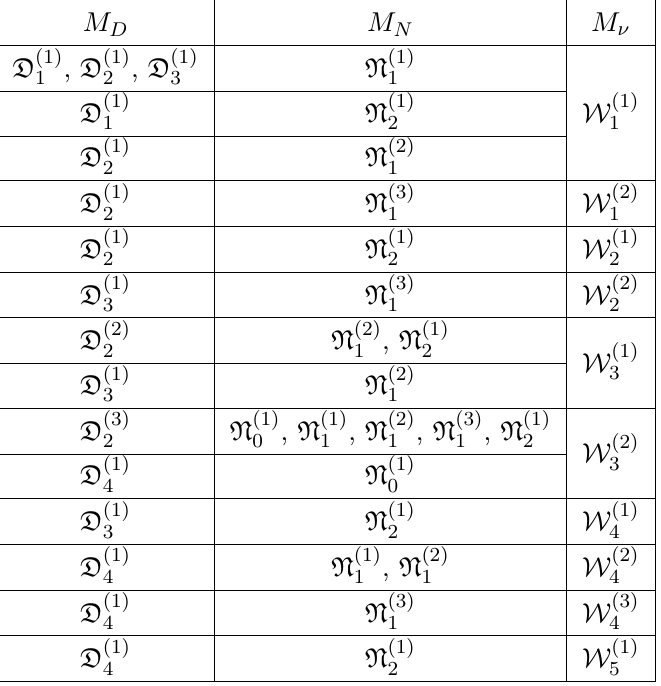
Table 5. Textures for the effective neutrino mass matrix M ν in the type-I seesaw mechanism with two RH neutrino fields. D (1) are the texture-zero patterns for the Dirac neutrino mass − D (1) 1 4 matrix M and N (1) are those for the RH Majorana neutrino mass matrix M — see (4.22) − N (1) D N 0 2 and (4.23). The explicit forms of the resulting M textures W (1) are given in table − W (1) ν 1 5